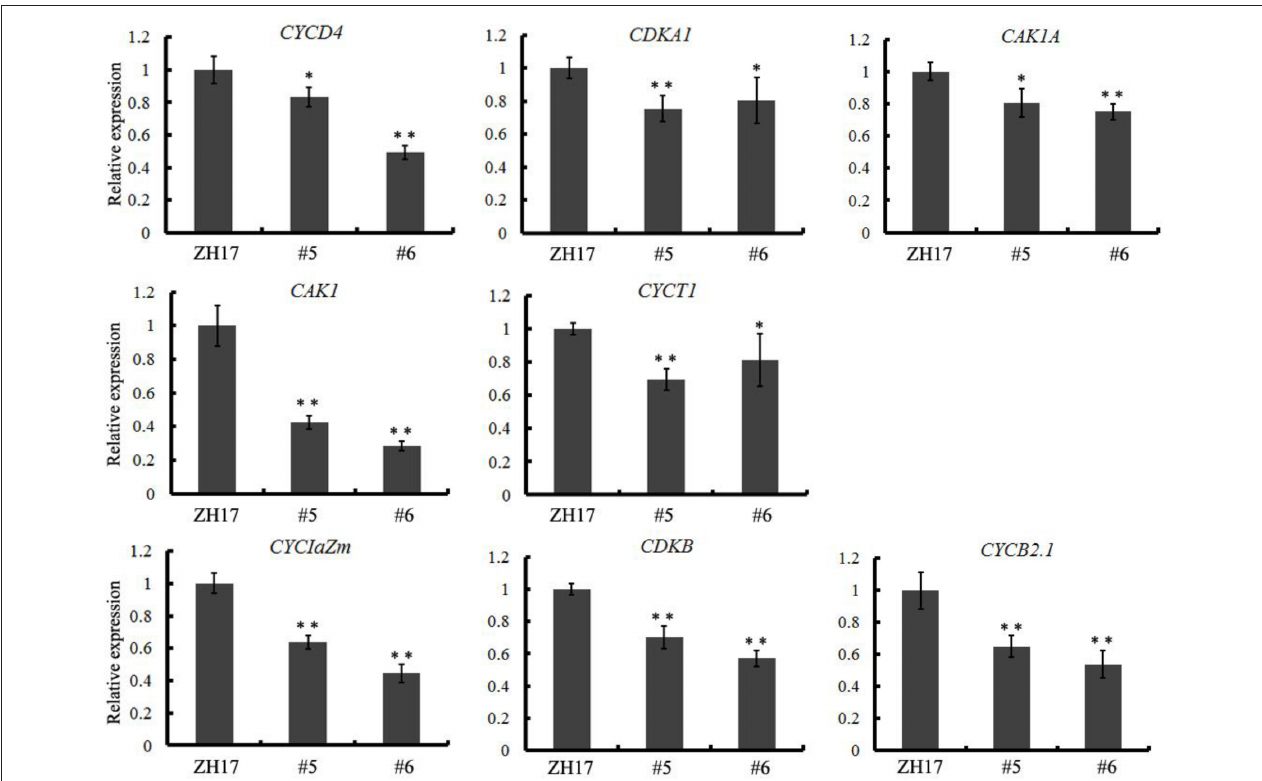
FIGURE 8 | Quantitative RT-PCR analysis revealed that eight cell-cycle-related genes, including five G1/S-phase genes ( CDKA1 , CAK1 , CAK1A , CYCT1, and CYCD4 ) and three G2/M-phase genes ( CYCIaZm , CDKB, and CYCB2.1 ), were significantly down-regulated in the transgenic line compared with the control. The expression levels were determined using 6–8cm young panicles from at least five plants, the values are means ± SD, * P < 0.05 , ** P < 0.01 .